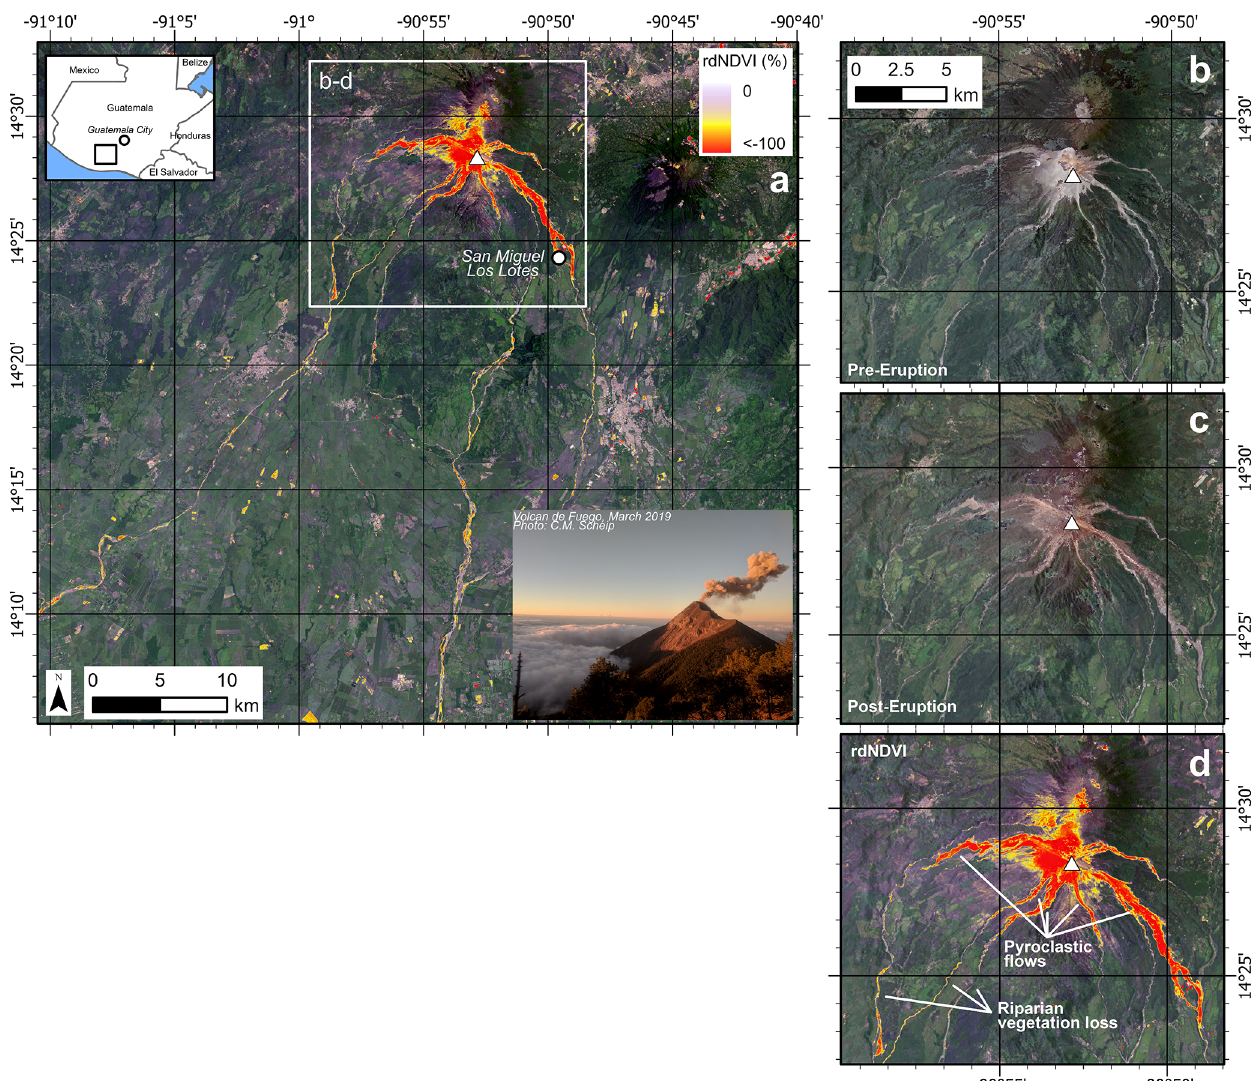
Figure 6. rdNDVI change detection images and greenest-pixel composites following the 3–5 June 2018 volcanic eruption of Volcán de Fuego 40km southwest of Guatemala City, Guatemala. White triangle denotes summit. Parameters – dataset: Landsat 8; event date: 3 June 2018; pre-window: 12 months; post-window: 3 months; maximum cloud cover: 30%; slope threshold: 0.05 ◦ . (a) rdNDVI across the event illustrates loss of vegetation on upper flanks of the volcano summit and influence of pyroclastic flows on volcano flanks and downstream areas. San Miguel Los Lotes is a small community on the southeastern flanks of Volcán de Fuego that was heavily impacted during the eruption, including at least 25 fatalities. Note significant riparian vegetation loss in channels flowing south to southwest away from volcano. Base image is post-eruption. (b–d) Close-up detail of Volcán de Fuego. (b) Pre-eruption greenest-pixel composite image of volcano. Note the limited vegetation near the summit. (c) Detailed image of volcano summit post-eruption greenest-pixel composite. A typical color composite pre-post comparison can be performed to locate areas impacted by the eruption and resulting pyroclastic flows, however, rdNDVI as shown in (d) provides a more rapid approach to identifying impacted areas and adds additional detail such as riparian vegetation loss that is more difficult to observe in a standard (RGB) color image comparison. (d) rdNDVI of the volcano following the eruption with notable observations annotated. Panels (b–d) have the same scale. Panels (a) and (d) use the same rdNDVI color scale. rdNDVI and greenest-pixel composite data exported from HazMapper, available at https://go.ncsu.edu/hazmapper-fuego (last access: 29 April